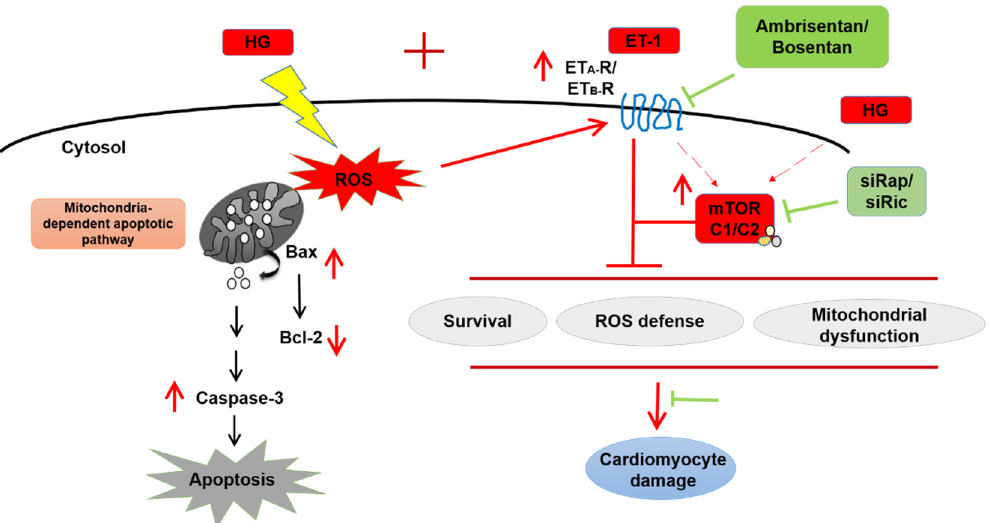
Figure 5. Schematic representing the interplay between ET-1/ET A /ET B receptor and mTOR signaling under HG conditions in H9c2 cells. HG treatment leads to increased production of ROS, mitochondrial damage, decreased expression of survival markers, and increased expression of apoptosis markers. These HG-induced cardiomyocyte damages were ameliorated by inhibition of endothelin receptors ET A -R alone, both ET A -R/ET B -R, or partial suppression of mTOR complex. HG: High glucose; ROS: Reactive oxygen species; ET-1: Endothelin-1; siRap: silencing Raptor; siRic: silencing Ric- tor.